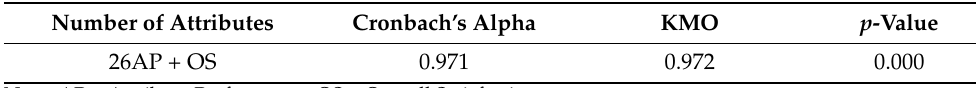
Table 4. Reliability and Validity Statistics.